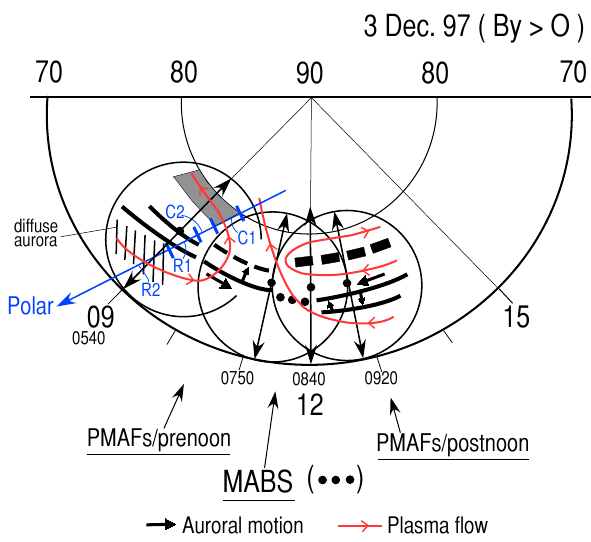
Fig. 1. Schematic illustration of aurora and plasma convection in MLT/MLAT coordinates representing the interval 05:40–09:30UT on 3 December 1997. Approximate fields of view (at 630.0nm) of the MSP at Ny ˚Alesund are indicated by double-arrowed meridional lines for the times 05:40UT, 07:50UT, 08:40UT, and 09:20UT. Magnetic north is up. Circles mark the FOVs of the ASC (630.0nm) at the same selected times. Auroral motions are indicated by arrows attached to the respective forms. Plasma convection streamlines are marked